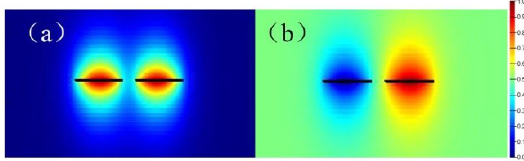
Figure 8. ( a ) The symmetric mode filed and ( b ) the antisymmetric mode filed.